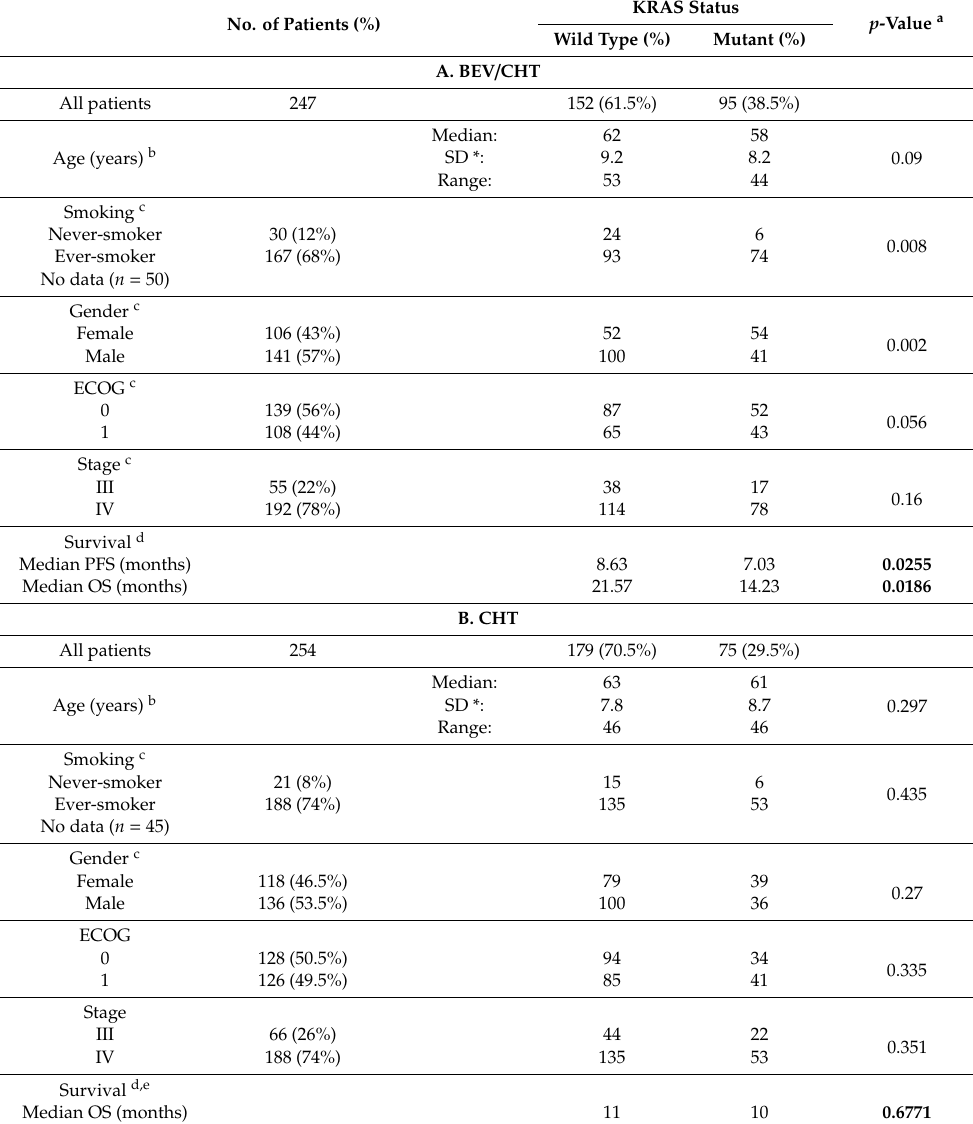
Table 1. Patient characteristics in the bevacizumab / chemotherapy (BEV / CHT) and chemotherapy (CHT)